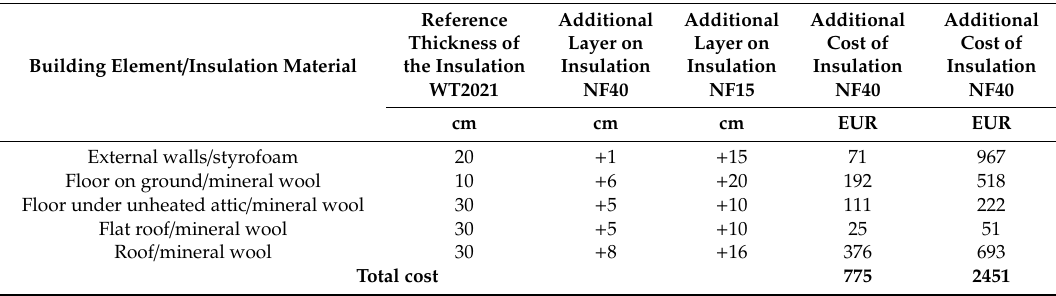
Table 14. Additional cost of insulation for the NF40 and NF15 standards.